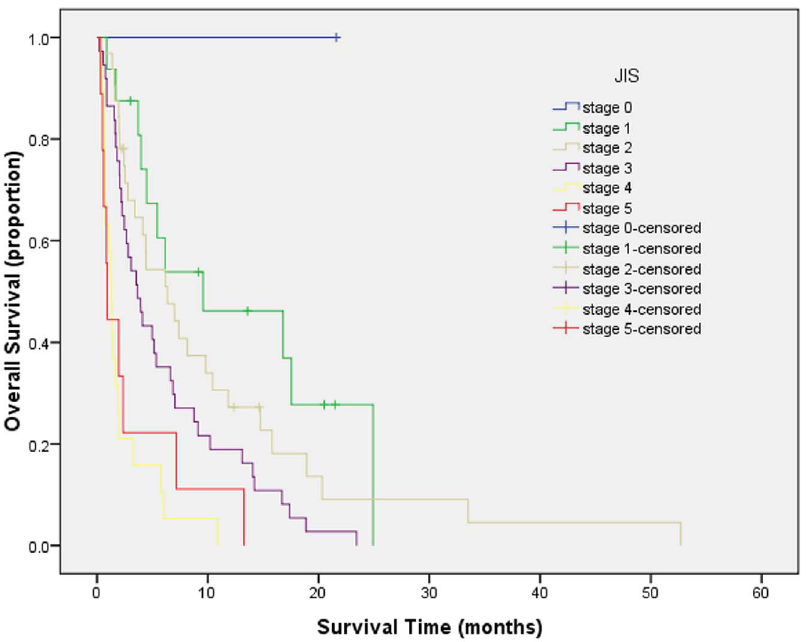
Figure 6. Survival curves for patients with unresectable hepatocellular carcinoma who were stratified according to the Japan Integrated Staging System. Score 0 versus 1, P=.322; score 1 versus 2, P=.655; score 2 versus 3, P=.046; score 3 versus 4, P=.000; score 4 versus 5, P=.980. The difference was significant only between scores of 2 and 3 and between scores of 3 and 4.